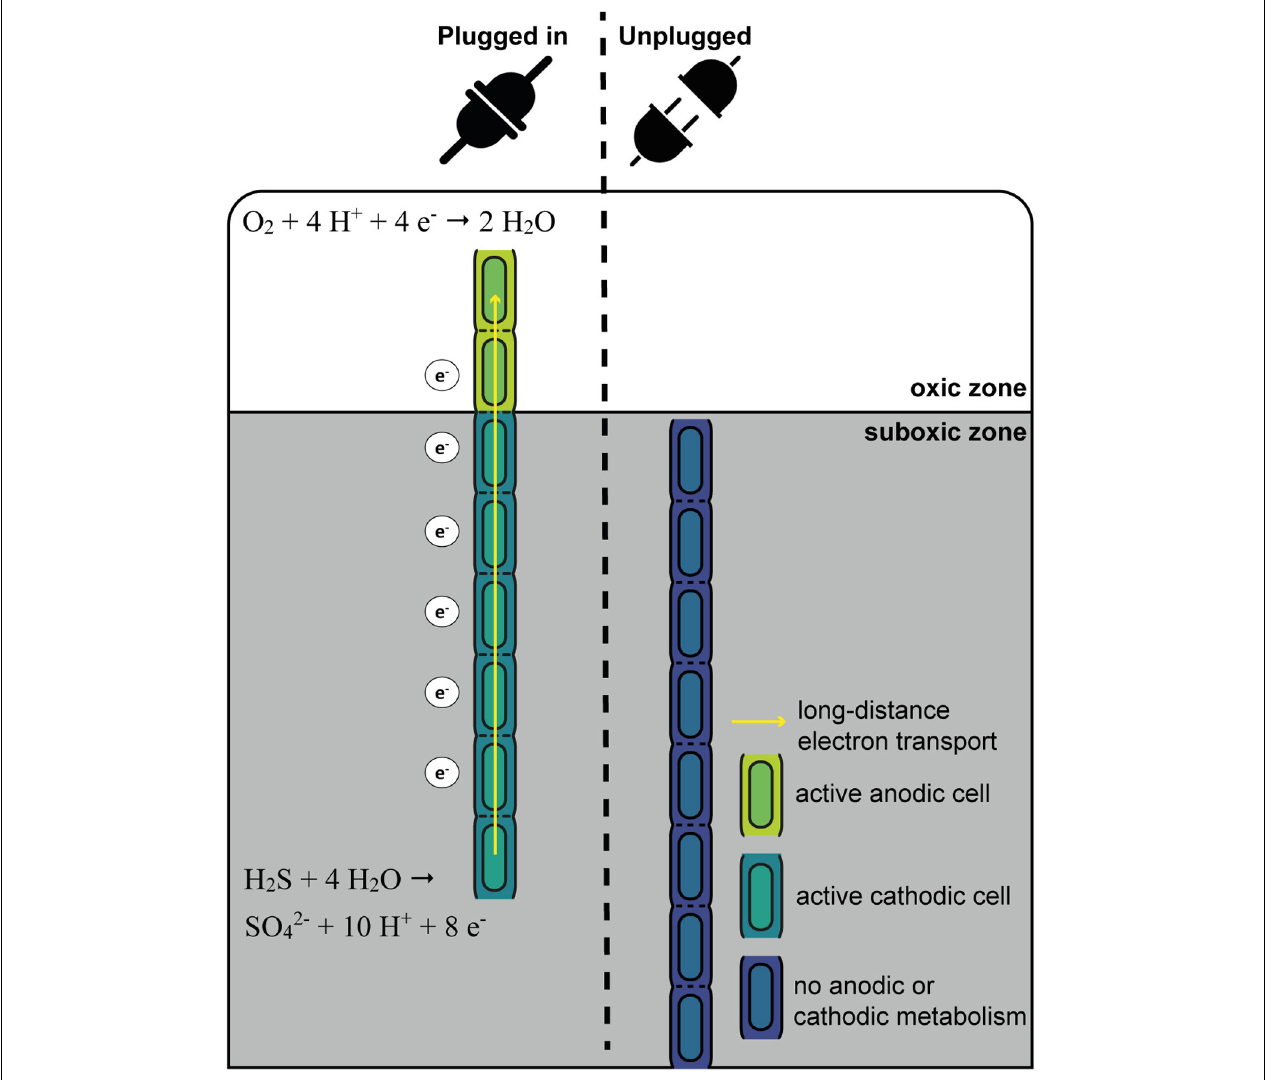
FIGURE 7 | Schematic overview of the “oxygen pacemaker” hypothesis. A filament can be in two states: “plugged in” and “unplugged.” If a filament is “plugged in,” part of it has access to oxygen. Only in this state has the filament the capacity to oxidize sulfide via long-distance electron transport. If a filament is “unplugged,” access to oxygen is lost and the filament no longer has the capacity to perform long-distance electron transport and thus generate energy.